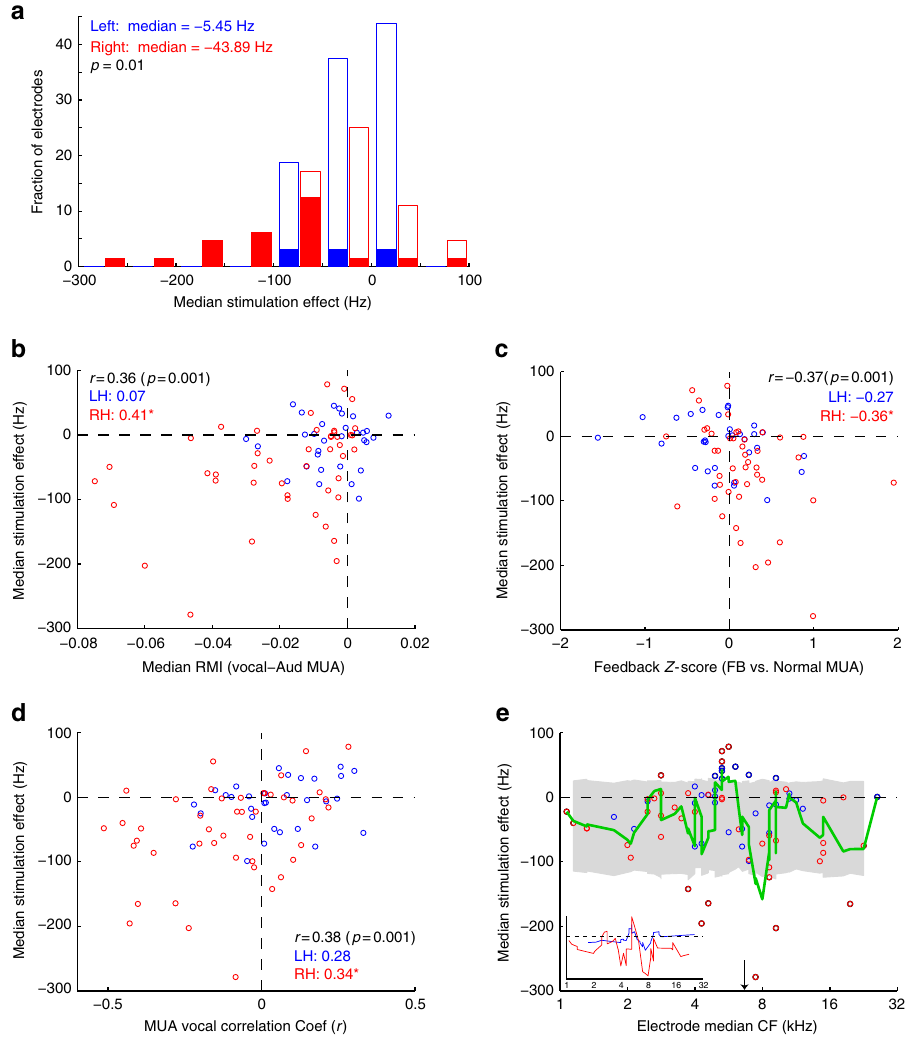
Fig. 9 Correlation between neural recording and microstimulation effects. a Histogram of median vocal frequency changes during microstimulation for each electrode site (Shaded: p < 0.05, Wilcoxon signed-rank within electrode). Results are plotted separately for right and left hemispheric electrodes, with stronger effects on the right ( p = 0.01, Wilcoxon rank-sum between hemispheres). b Scatter plot comparing stimulation effects and the degree of vocal suppression (vocal-auditory RMI) of multi-unit activity (MUA) at the matched recording site. Signi fi cant correlations were present for the population, as well as in the right hemisphere (* p < 0.01), but not left hemisphere. c Scatter plot showing negative correlation between stimulation and feedback sensitivity. d Plot comparing microstimulation and vocal compensation correlation coef fi cients. Sites with negative neural-vocal correlations showed greater decreases in vocal frequency during stimulation, with positive correlation sites showing the opposite. e Comparison of microstimulation effects by electrode frequency tuning, demonstrating largest decreases clustered around 8 kHz, just above mean trill frequency (arrow), and increases around 5 – 6 kHz, just below mean trill frequency (Green: moving average; shaded: 95% CI). Inset: moving average curves separated by right (red) and left hemispheres using Kruskal – Wallis non-parametric ANOVAs. False discovery rate (FDR) calls (i.e., Fig. 1c) by low pass fi ltering, followed by subtraction of the mean corrections were applied for the multiple time bins tested, with p <0.001 frequency in a window around the feedback trigger ( − 50 to + 50ms). Frequency considered signi fi cant. Due to the large number of calls compared, possibly contours were then aligned by feedback onset, using 100 ms for the reference resulting in additional falsely positive p -values, we also required mean feedback normal (ampli fi ed only) calls. The second animal (mm058) had a tendency to responses deviate from normal by 1.96 SEMs (95% CI for the mean estimate). For preface its vocalizations with a short “ peep ” sound, which caused multiple early individual analysis of the + 2 and − 2 responses within individual time-bins, post shifted feedback triggers, as a result we only included the 50 ms before the trigger in hoc Bonferroni corrections were applied, followed by FDR corrections across time this animal. Also, because of this early triggering, signi fi cant variability was noted bins. in the averaged pre-feedback frequency contour of this animal, a result of variable timing of the vocal onset. This was corrected by calculating a linear scaling factor to better normalize the pre-trigger frequency contours between feedback and normal Neural data analysis . Responses to individual vocalizations were calculated by conditions, which was then applied to all subsequent time points. To remove expected frequency contours, and reduce the effects of day to day variability, as comparing the fi ring rates before and during self-initiated vocalizations. Pre-vocal before, the mean contour of normal calls for each session was subtracted from that activity was assessed by randomly selecting 1000 time bins, with lengths matching session ’ s individual call contours prior to further averaging. Final results showed vocal duration, from the 4s preceding vocal onset, and calculating the average fi ring rate of 500 bins with the quietist microphone signal (acoustic background), increasing standard error (SEM) in later portions of the calls due to both increasing variability between different calls and decreasing number of samples. We thereby minimizing the effects of colony noises on calculations. A window of 500 determined the onset timing of signi fi cant feedback compensation in the mean ms immediately before vocal onset was excluded from this calculation because of frequency contours by calculating p -values for each individual time bin (2.6ms) previous work 14 indicating pre-vocal suppression. The response to each